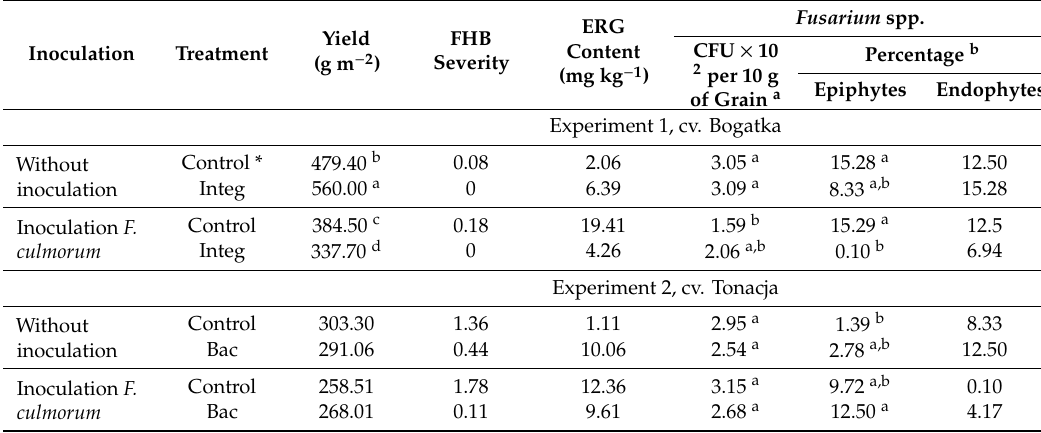
Table 4. Grain yield, severity of Fusarium head blight (FHB), ergosterol (ERG) content, and colonization of winter wheat by Fusarium